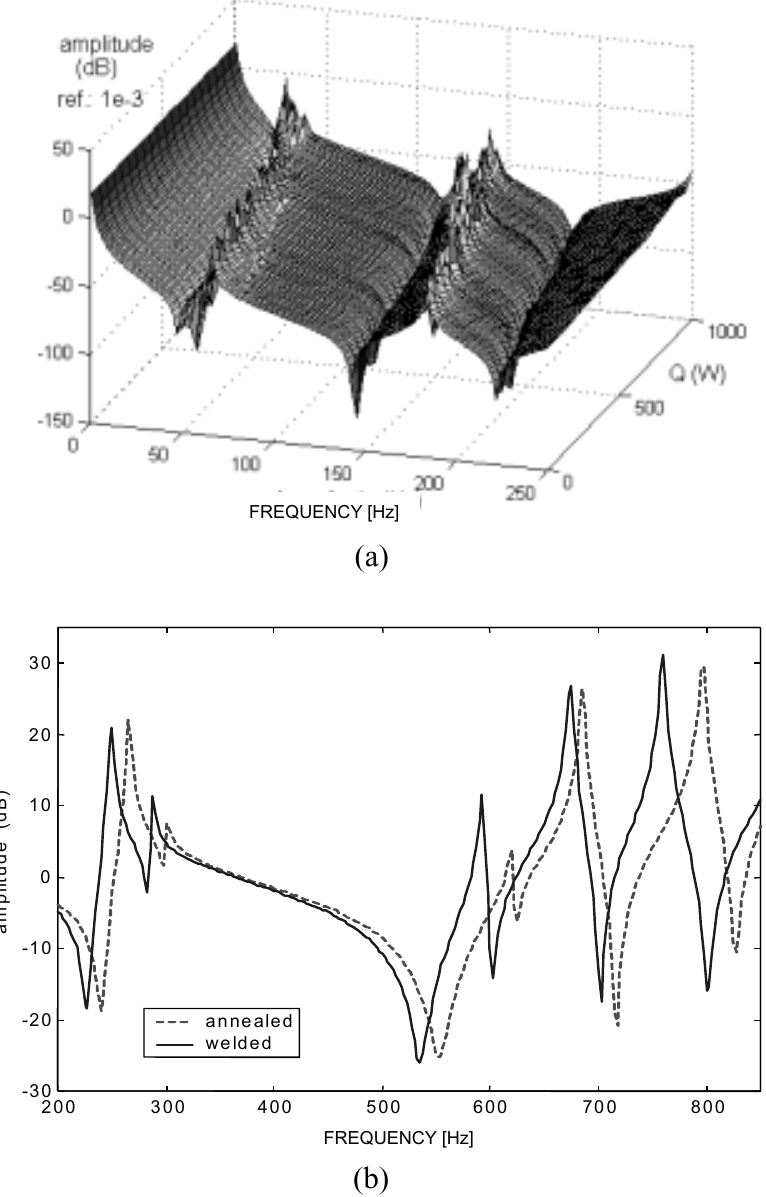
Fig. 1. (a) amplitudes of a typical numerically simulated driving point FRF for different values of the welding power; (b) amplitudes of an experimentally acquired FRF of a plate in two conditions: without residual stresses (annealed) and with residual stresses (welded) (from Vieira Jr.